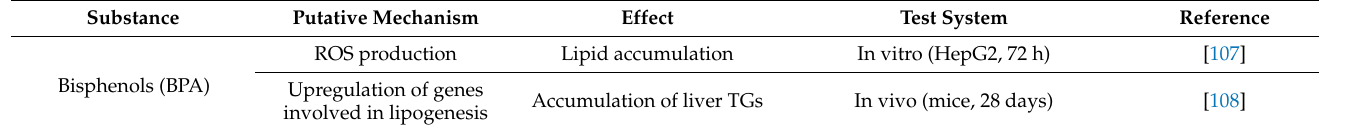
Table 2. Selected compounds affecting the liver and inducing metabolic